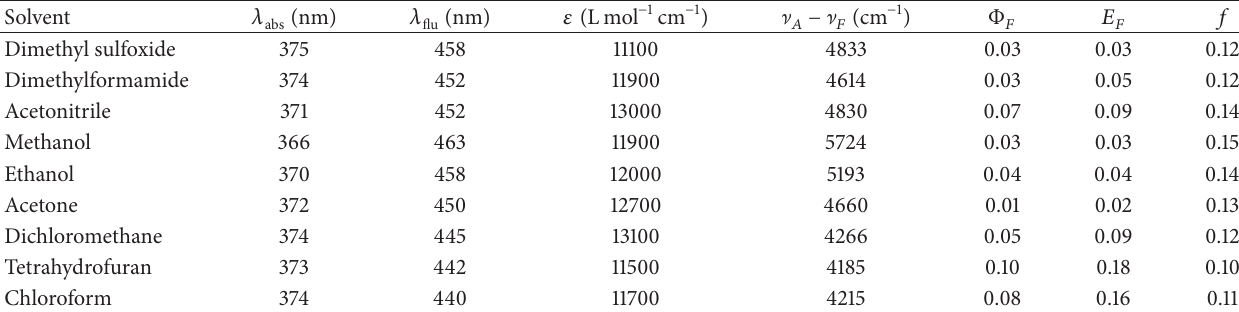
Table 1: Photophysical characteristics of the MD1 in organic solvents of different polarities (see text).